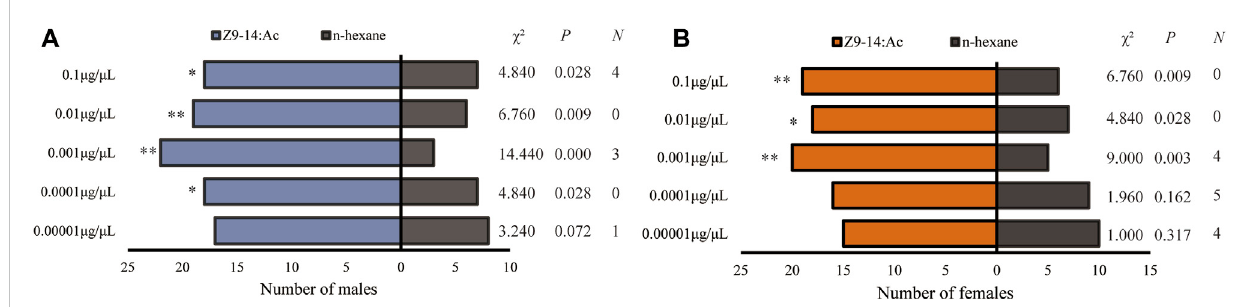
FIGURE 4 Olfactory responses of male (A) and female (B) Harmonia axyridis to Z9-14:Ac in a Y-tube olfactometer. Twenty- fi ve females or males that made a choice were tested for each treatment. N: the number of non-responses. The asterisks indicate signi fi cance differences at p < 0.05 (*) and p < 0.01 (**).